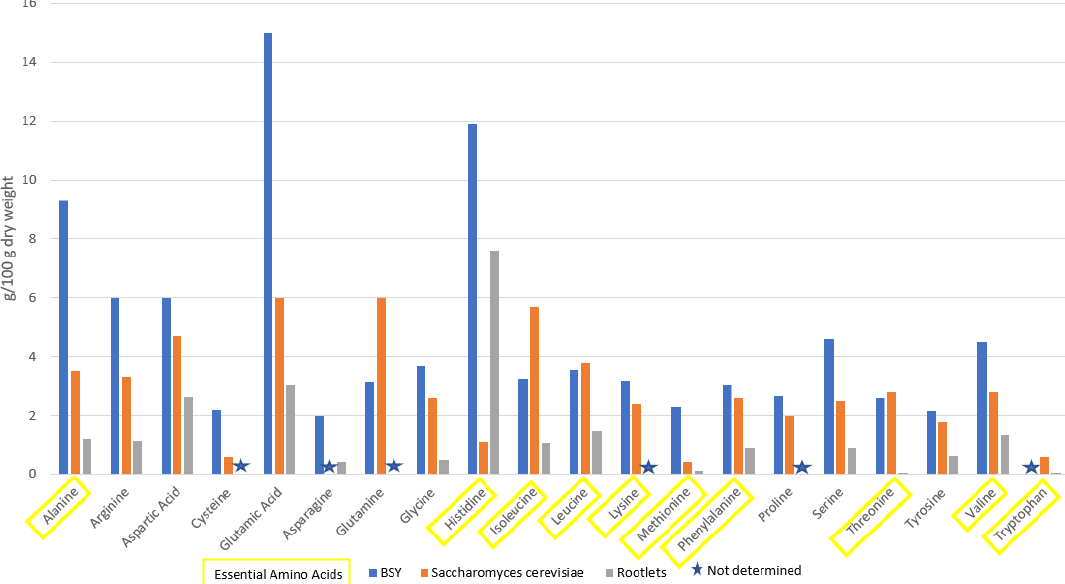
Figure 1. Amino Acid Profiles of Brewer’s Spent Yeast (BSY) in comparison to Saccharomyces cerevisiae and rootlets, with the essential amino acids highlighted in yellow [20,33,34].